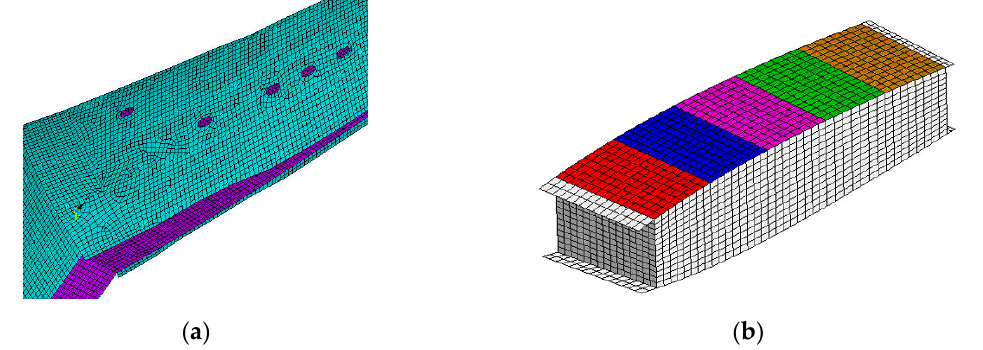
Figure 3. ( a ) Discretization of lower skin in the area of access holes; ( b ) chordwise panel thickness variation (right).